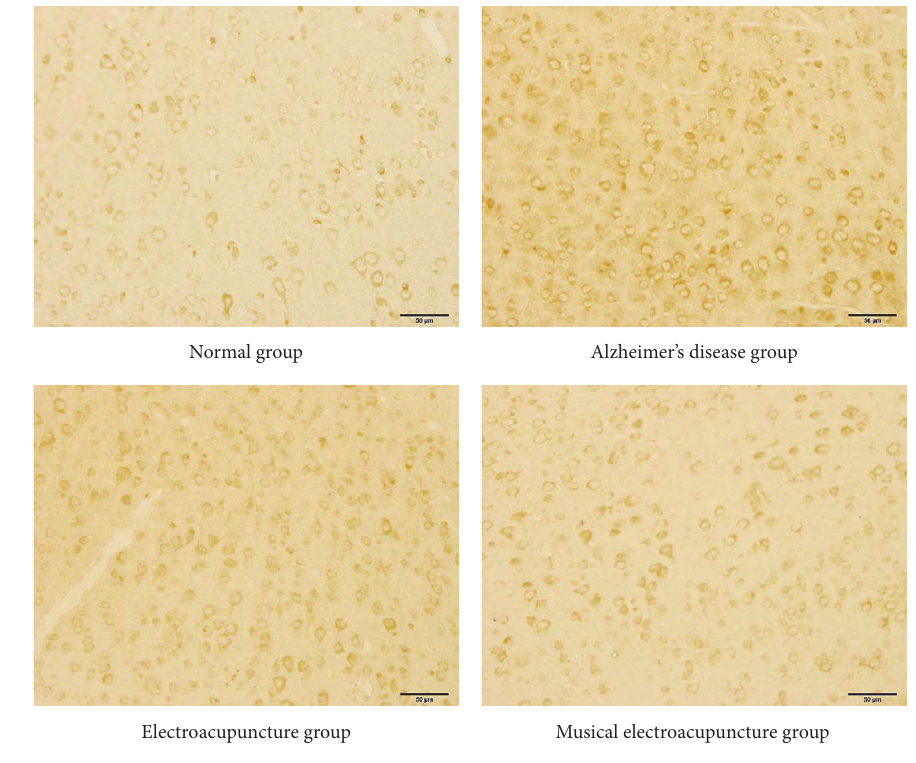
Figure 6: The IHC images of frontal lobe.